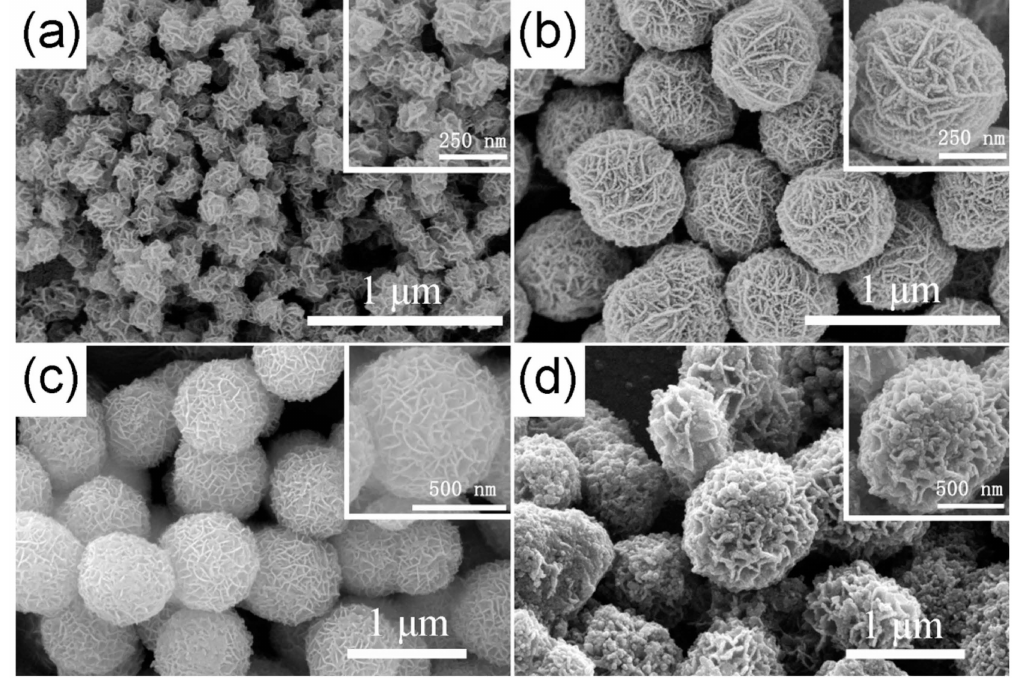
Figure 2. The FESEM images of the as-prepared TiO 2 hierarchical nanospheres under di ff erent solvothermal reaction times: ( a ) 6 h, ( b ) 12 h, ( c ) 24 h, and ( d ) 48